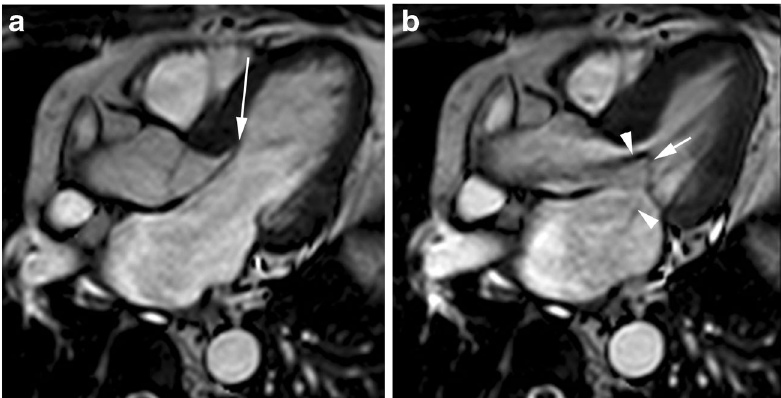
Fig. 5 Abnormalities of mitral apparatus in classic HCM phenotype. 44- year-old woman with obstructive HCM, systolic anterior motion of the anterior leaflet of the mitral and mitral regurgitation. Horizontal long-axis SSFP cine MR images at ( a ) end-diastole and ( b ) mid-systole show an